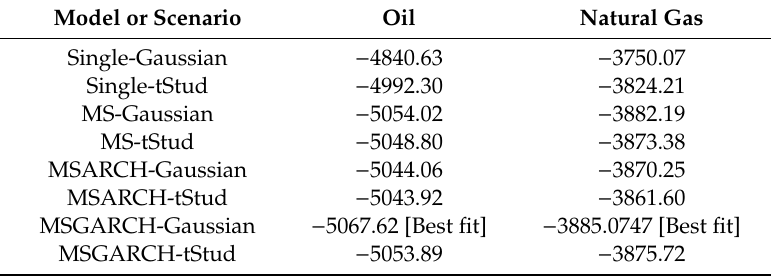
Table 2. Single and multiple regime AIC fitting test for the three commodities’ time series of interest.